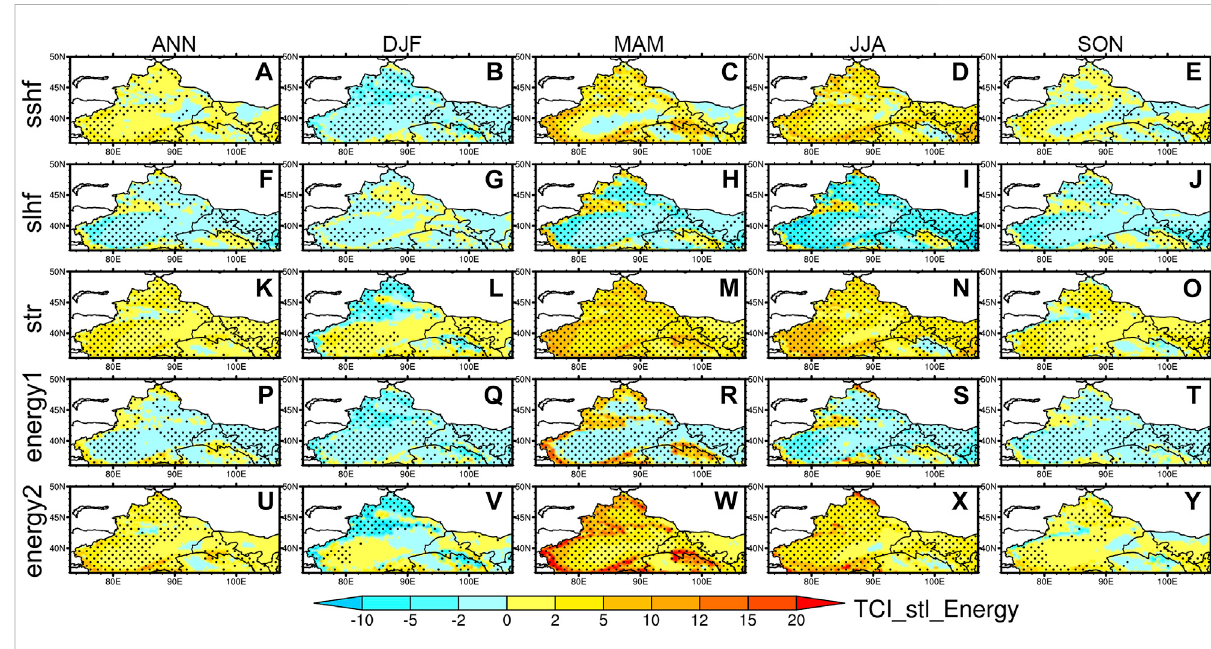
FIGURE 8 Spatialdistributionsoftheannualandseasonalcouplingindexofstl1withsshf,slhf,str,energy1,andenergy2.Therestofthecaptionisthesame as in Figure 6.